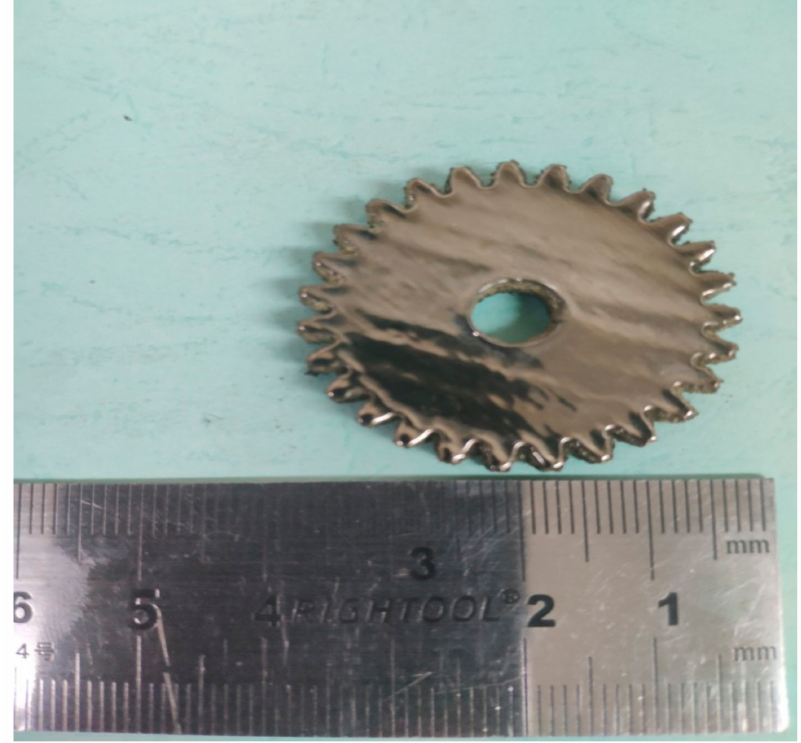
Figure 8. SLM-fabricated Zr 60 Fe 10 Cu 20 Al 10 BMG part (diameter 35 mm and height 5